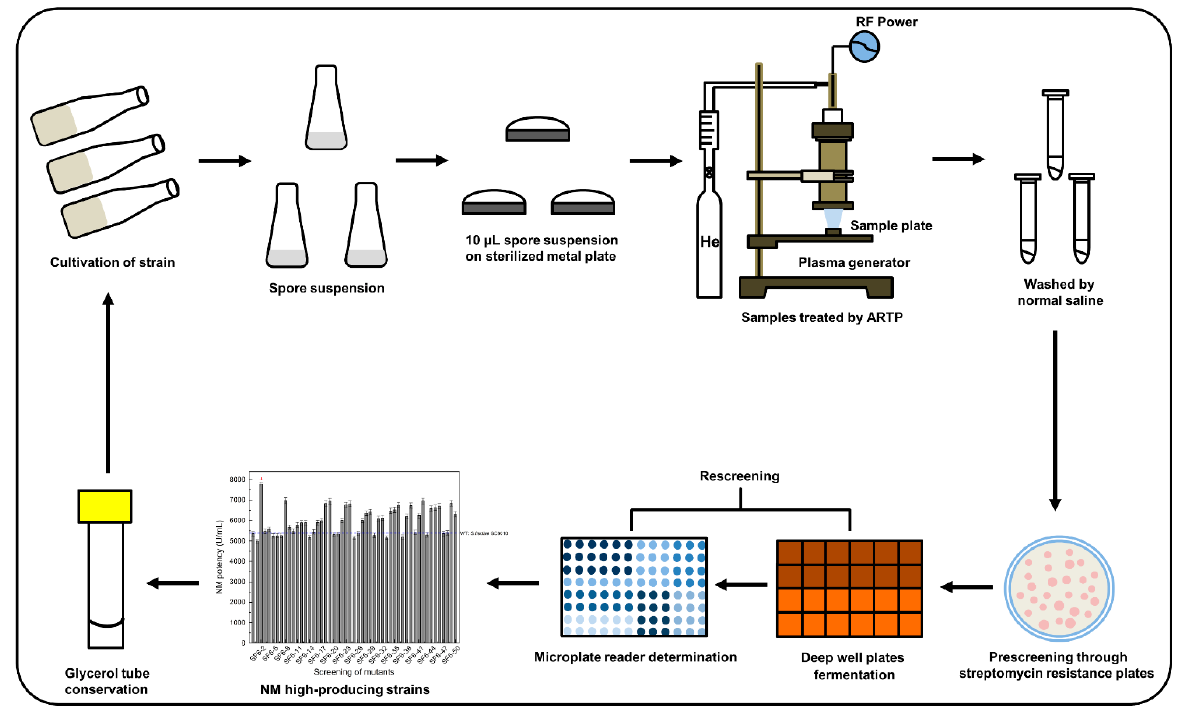
Figure 1. ARTP mutagenesis and screening schematic. RF: radio-frequency.